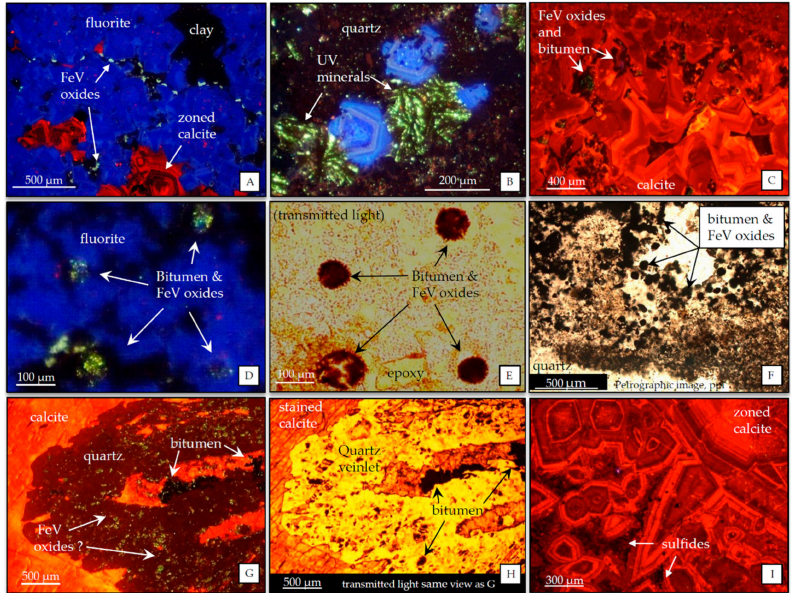
Figure 8. Cathodoluminescence (CL) images of samples from the study areas. ( A ) Blue fluorite with zoned calcite and Fe-rich clay coating calcite filling in the porosity. Green luminescing Fe-V oxides follow fracture and occupy pore space, Marie mine, PMD; ( B ) U-V minerals luminesce bright green with hexaoctahedral blue and lilac zoned fluorite in vug of a silicified breccia from the Old Glory mine; ( C ) Zoned calcite with bitumen and Fe-V oxides filling in the porosity, Lisbon mine, LMD; ( D ) Fluorite and with Fe-V oxides and bitumen spheres, Marie mine, PMD; ( E ) Transmitted light view of D; ( F ) Spheres of bitumen and Fe-V oxides in quartz, Old Glory mine, PMD; ( G ) Corroded quartz veinlet filled in by calcite and bitumen. Fe-V oxides luminesce green in the bitumen; ( H ) Quartz appears white and bitumen black in the transmitted light view of G; ( I ) Zoned calcite with bitumen and sulfides filling in the porosity, Lisbon mine, LMD. Figure modified from Moore-Nall and Lageson